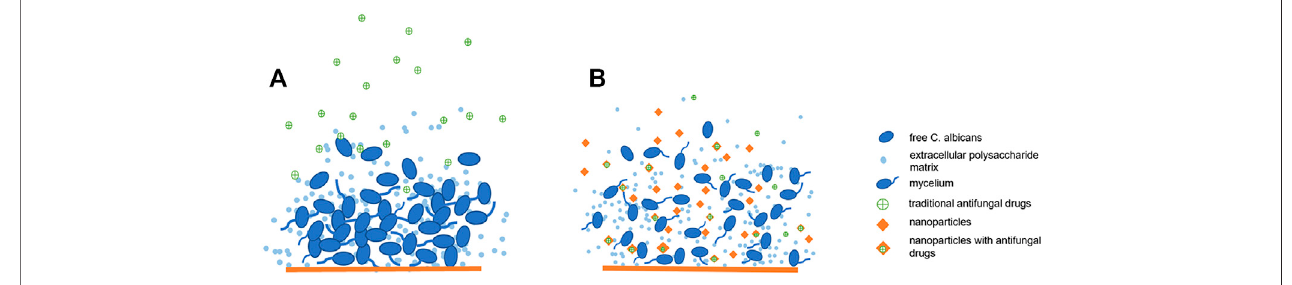
FIGURE 2 | Nanoparticles have anti-bio fi lm effect: (A) . Traditional antifungal drugs have dif fi culty passing through bio fi lms: (B) . Nanoparticles have anti-bio fi lm effect and can improve the bioavailability of antifungal drugs.